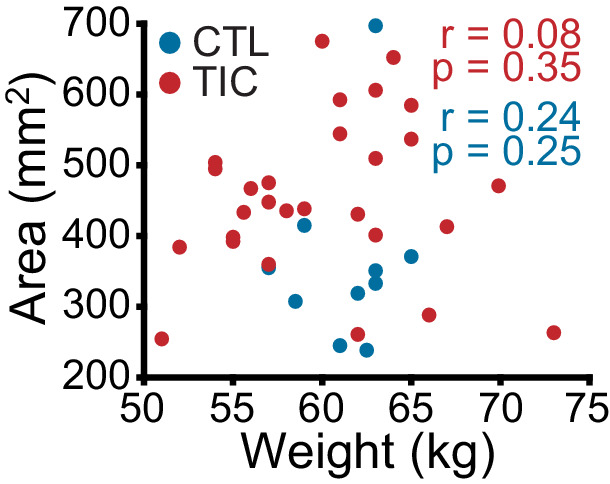
Tricuspid valve anterior leaflet area change does not correlate with animal weight.Correlations between animal weight and anterior leaflet area with correlation coefficient, r, and p-value for tachycardia-induced cardiomyopathy (TIC, red, n = 12, Pearson), and control (CTL, blue, n = 29, Spearman) to ensure the changes we observed in leaflet area were not the result of animal weights.